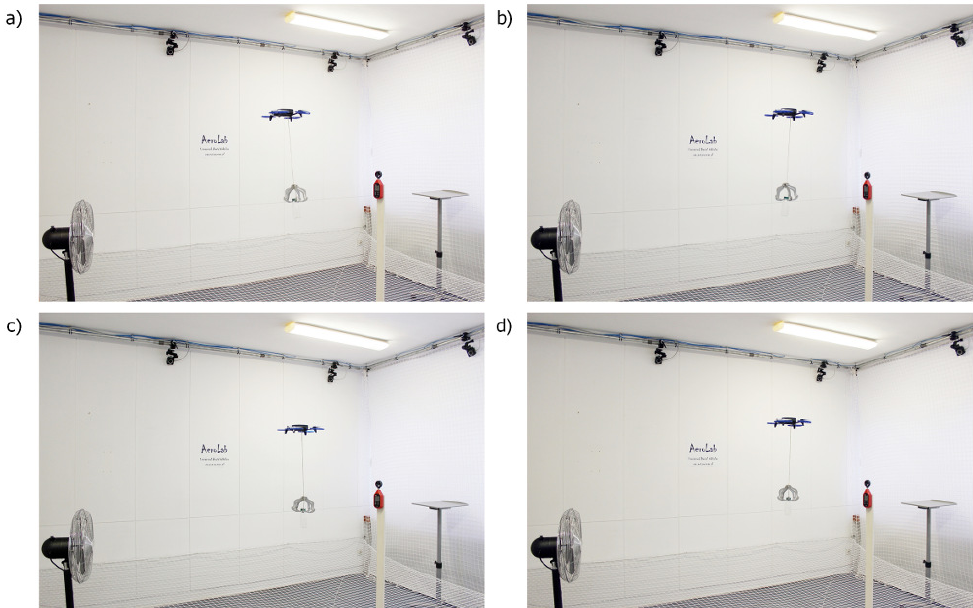
Figure 17. Snapshots from one of the initial research experiments with the auto-tuning of the altitude controller during the flight in the presence of wind gusts and with the mass attached to the UAV on a flexible